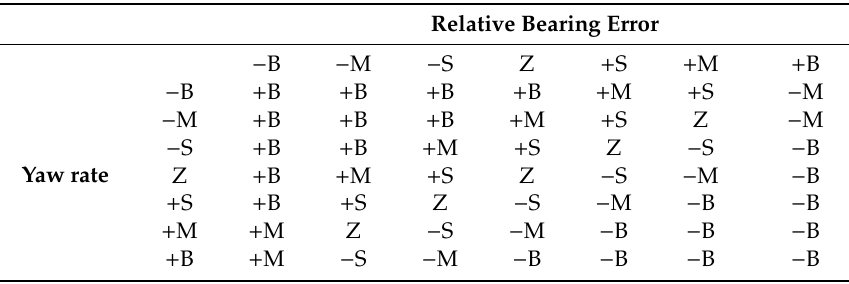
Table 6. The rule base for the second controller.